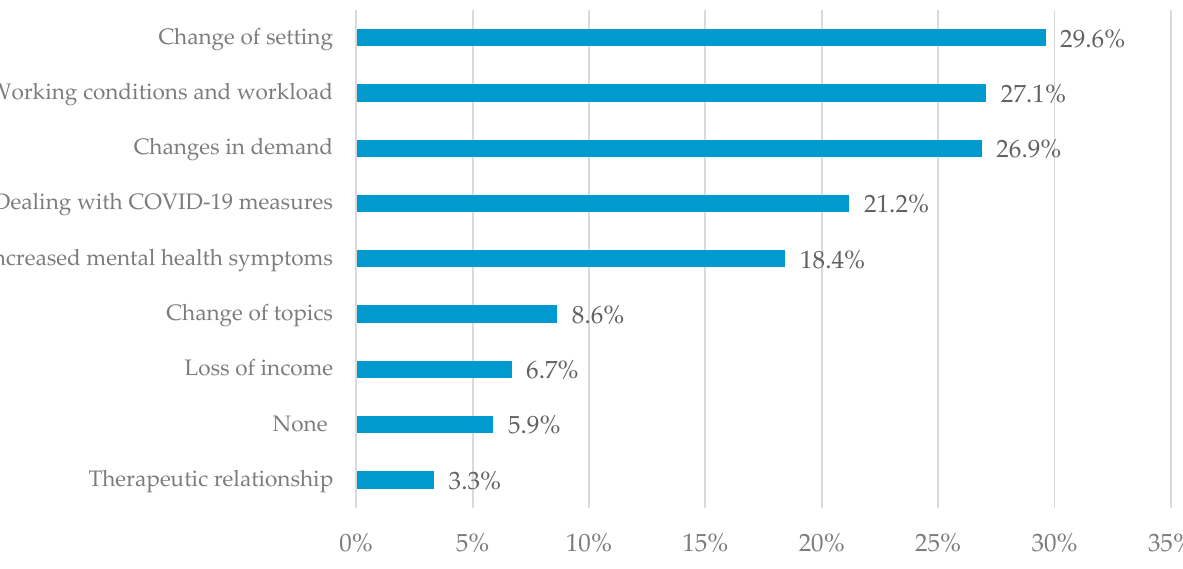
Figure 5. Experienced changes in psychotherapeutic work. The percentages of psychotherapists reporting each main category of response that emerged from the open-ended question, “What direct or indirect effects did the pandemic have on your work as a psychotherapist?”